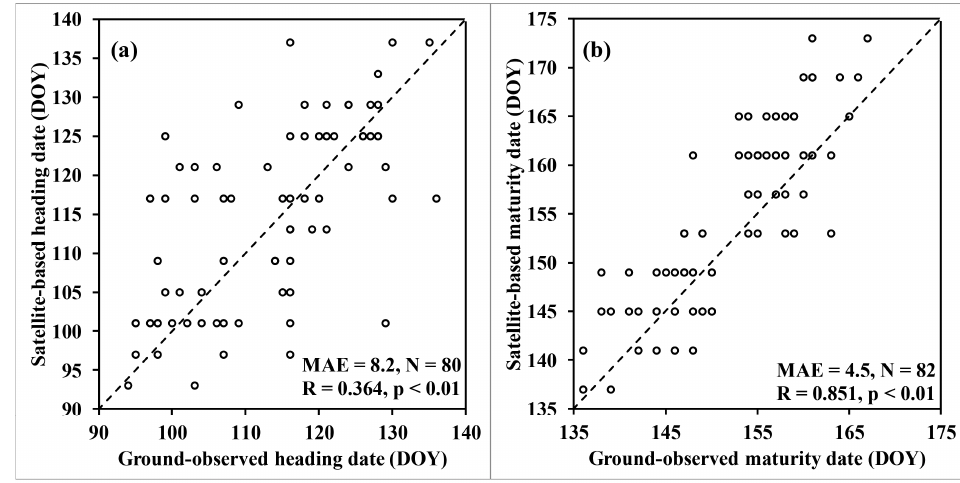
Figure 3. Comparison between the satellite-based and ground-observed heading date ( a ), and the maturity date ( b ) in the North China